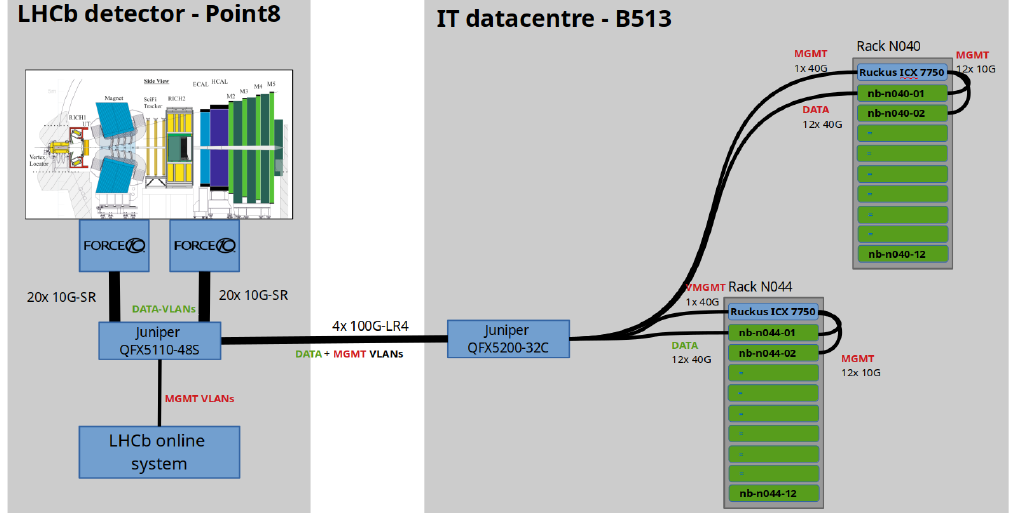
Figure 3. Case study